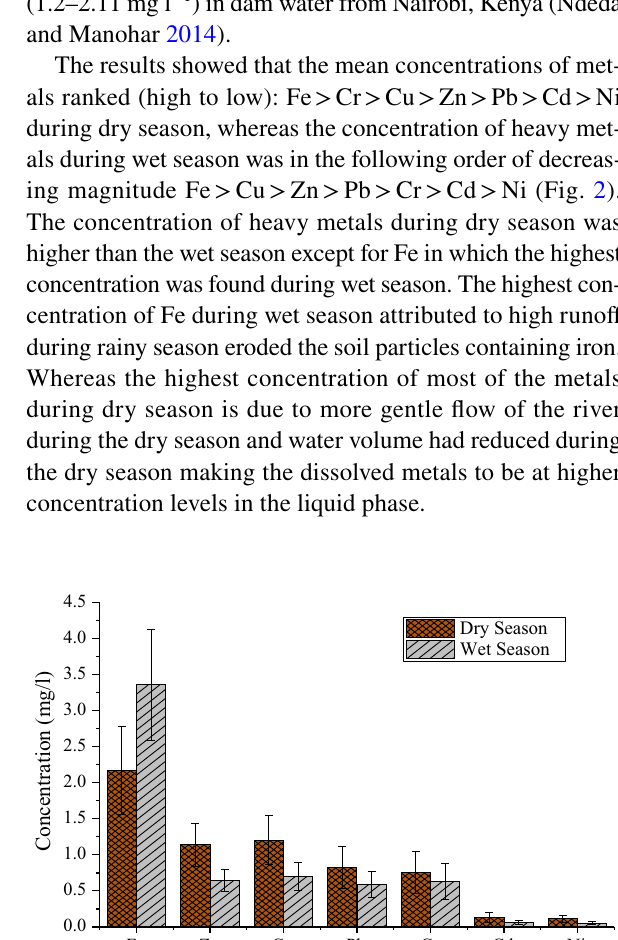
NS not statistical significant, SS statistical significant